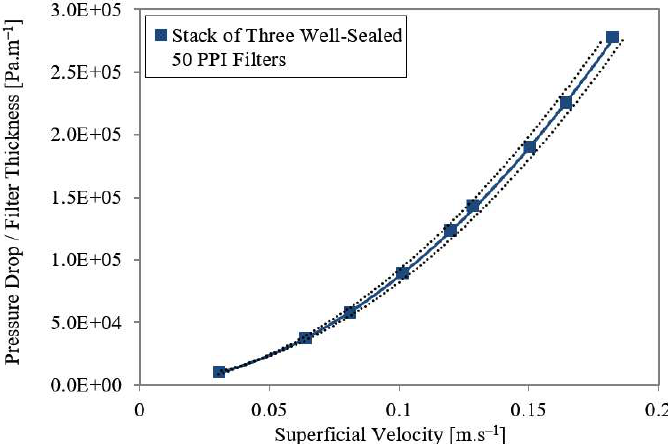
Figure 5. Empirically obtained pressure gradients of the stack of three well-sealed 50 PPI as a function of superficial velocity (the dark, solid curves) with a confidence interval of 95% margin of error (the dotted curves). Table 3. The measured and empirically obtained water properties, as well as the empirically obtained permeability coefficients, i.e., the Darcy k 1 and non-Darcy k 2